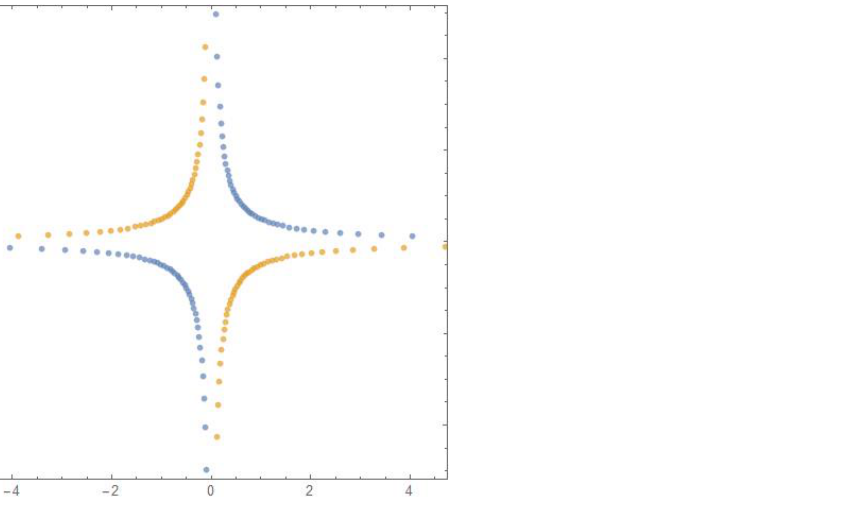
Figure 8. Helstrom classification is useless with centroids close to each other, while some classical methods work.